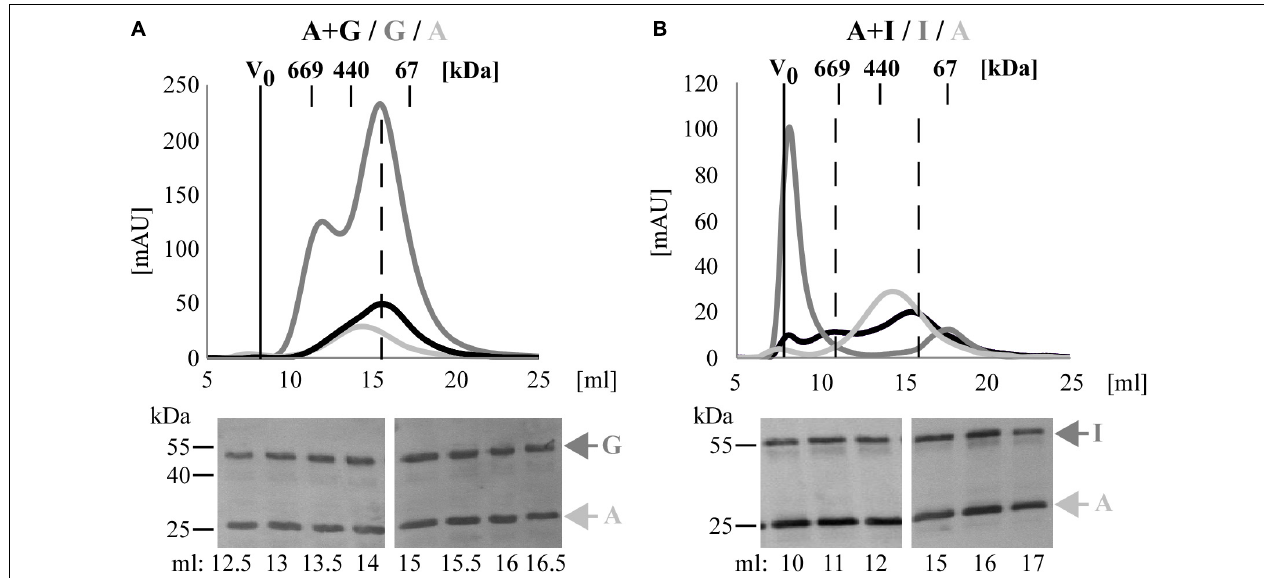
FIGURE 3 | C. trachomatis Pmps form heteromeric hMW Pmp complexes. Superimposition of SEC curves of co-refolded A + G (A) and A + I (B) Pmp oligomers and their respective homomeric complexes, obtained with Superose6 columns. Homomeric complexes are represented in shades of gray and heteromeric complexes in black. The void volume (V 0 ) is indicated. Elution volumes of globular standard proteins are indicated by short vertical lines. Vertical dashed black lines indicate peaks of the heteromeric Pmp complexes. Anti-His immunoblots of relevant SEC fractions are shown at the bottom. Arrows indicate Pmp